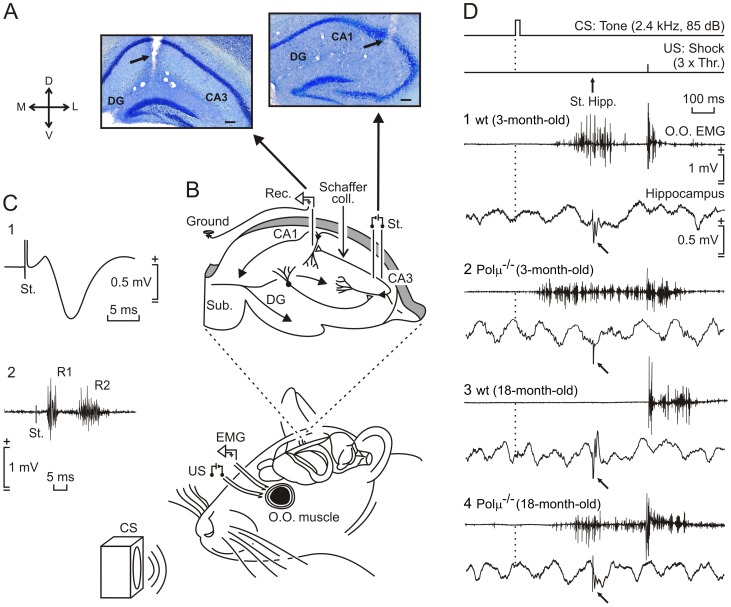
Experimental design for recording activity-dependent synaptic changes at the CA3-CA1 synapse during classical eyeblink conditioning.(A) Location of recording (left) and stimulating (right) electrodes implanted chronically in the CA1 and CA3 areas respectively. (B) Animals were implanted with electromyographic (EMG) recording electrodes in the orbicularis oculi (O.O.) muscle, and with stimulating electrodes on the supraorbital nerve for presentation of unconditioned (US) stimuli. Conditioned stimulus (CS) consisted of a tone preceding the US by 500 ms. Animals were also implanted with recording (Rec.) electrodes in the CA1 area and with stimulating (St.) electrodes at the ipsilateral Schaffer collaterals. (C) Example of fEPSP evoked at the CA3-CA1 synapse in an 18-month-old Polµ−/− mouse (1) and eyeblink evoked in the O.O. muscle by the electrical stimulation of the supraorbital nerve (2). (D) The top two traces illustrate the trace conditioning paradigm, and the moment at which a single pulse was presented to Schaffer collaterals (arrow, St. Hipp.). Samples of EMG activity of the O.O. muscle and hippocampal extracellular activity collected from the 9th conditioning session from an animal of each experimental group (1–4). Calibrations in (1) are for all of the records. Note fEPSPs evoked by the pulse presented to Schaffer collaterals (bend arrows).